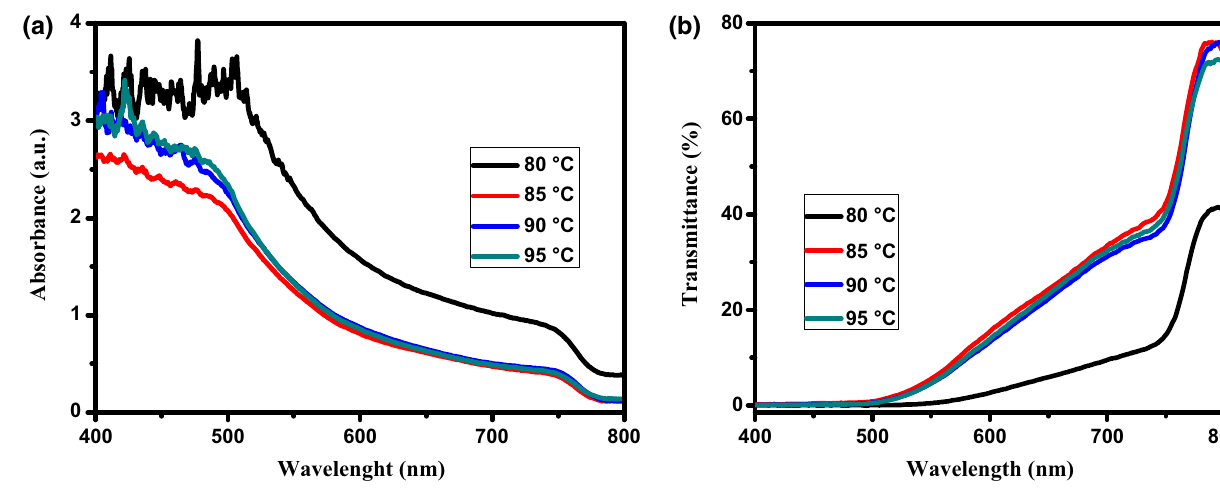
Fig. 6 a Absorption and b transmittance spectra of perovskite films annealed at different temperatures